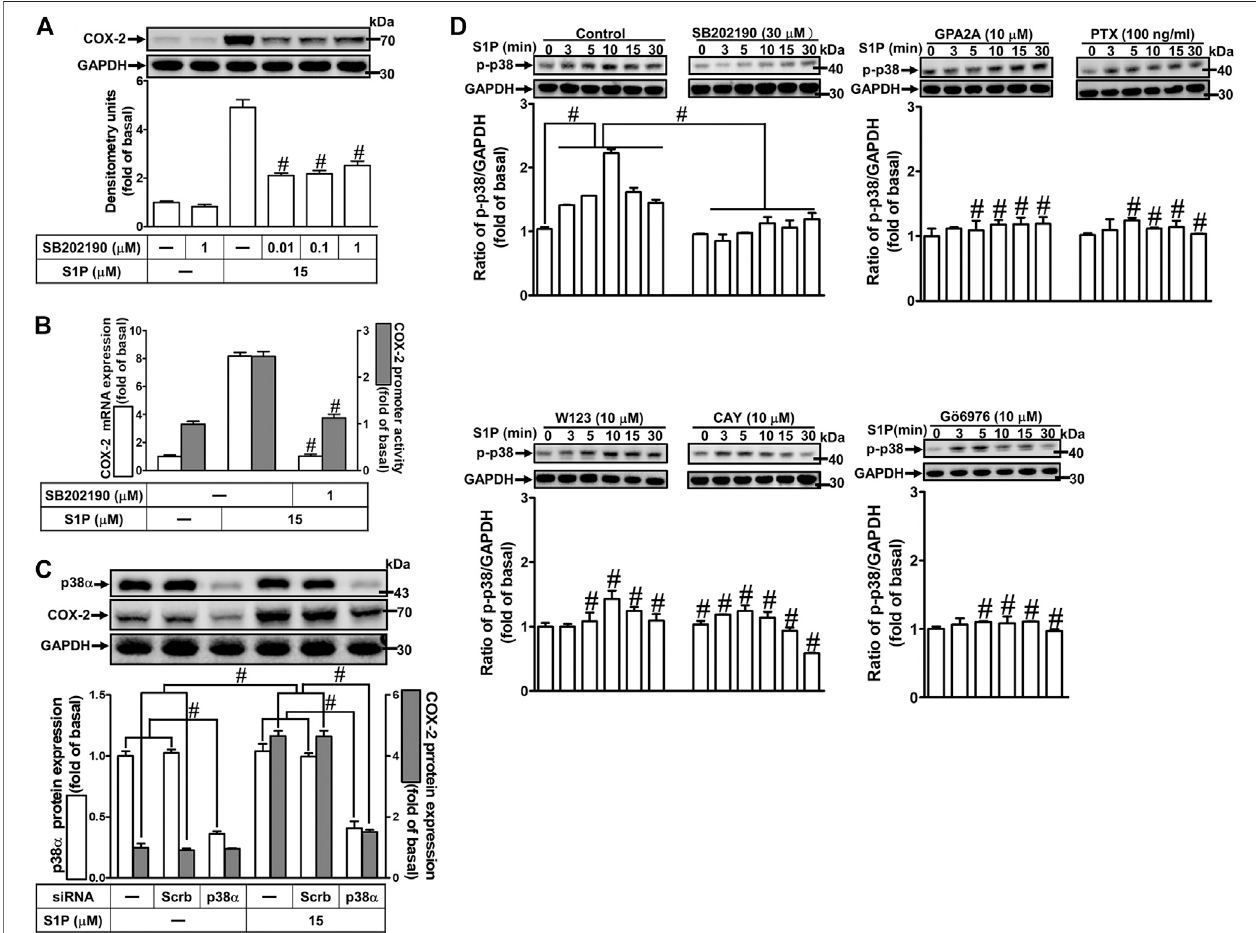
FIGURE 6 | S1P-induced COX-2 expression is mediated through p38 MAPK phosphorylation. (A) Cells pretreated with SB202190 for 1 h were followed by incubationwith15 μ MS1Pfor8 h. (B) CellsweretransfectedwithoutorwithCOX-2promoter-luciferasereportergene,pretreatedwithoutorwithSB202190(30 μ M)for 1 h, and then incubated with 15 μ M S1P for 4 h (mRNA) or 1 h (promoter). The levels of COX-2 protein, mRNA expression, and promoter activity were individually examined by Western blot, real time-PCR, and promoter assay. (C) Cells transfected with p38 α MAPK siRNA were incubated with S1P for 8 h. ( D ) Cells were incubated with S1P (15 μ M) for the indicated time intervals in the absence or presence of SB202190 (30 μ M), W123 (10 μ M), CAY (10 μ M), GPA2A (10 μ M), or Gö6976 (10 μ M) for 1 h and PTX (100 ng/ml) for 24 h. The cell lysates were collected and analyzed by Western blot. The fold of basal was de fi ned as normalization of the data to the respective “ 0, ” and then compared the data of corresponding time points ofcontrol vs inhibitor with a statistic method, as described in the section of Methods . Data are expressed as mean ± SEM of three individual experiments (n (cid:2) 3). # p < 0.05, as compared with the cells treated with S1P alone.